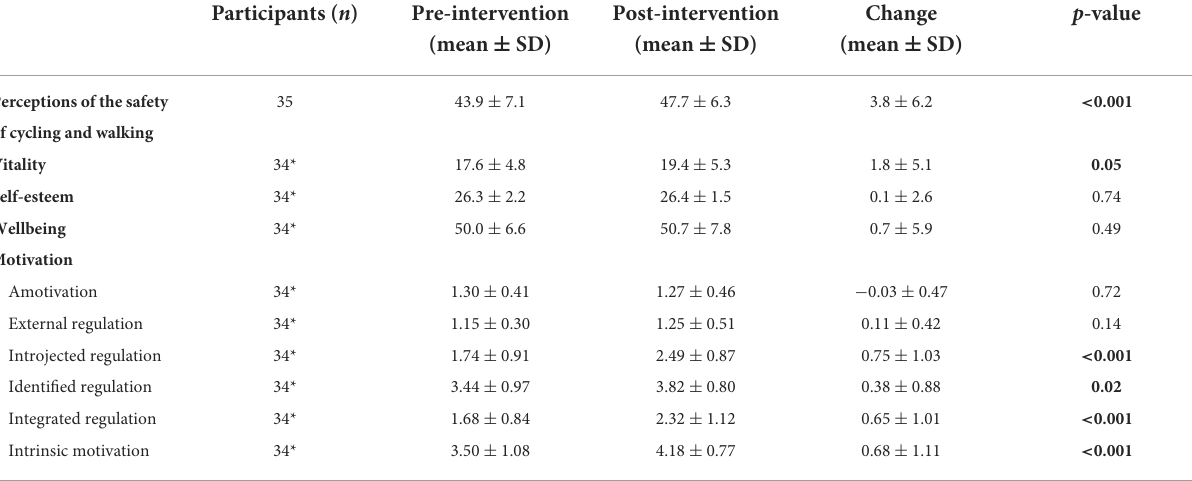
TABLE 7 Post intervention changes in perceptions of the environment for safe cycling and walking, wellbeing, self-esteem, vitality, and motivation (Edinburgh and London sites). Participants ( n